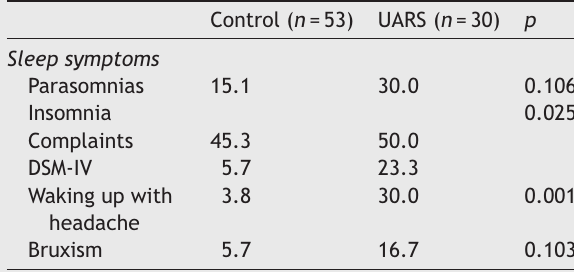
Frequency (%) of volunteers in the control and UARS groups, according to sleep